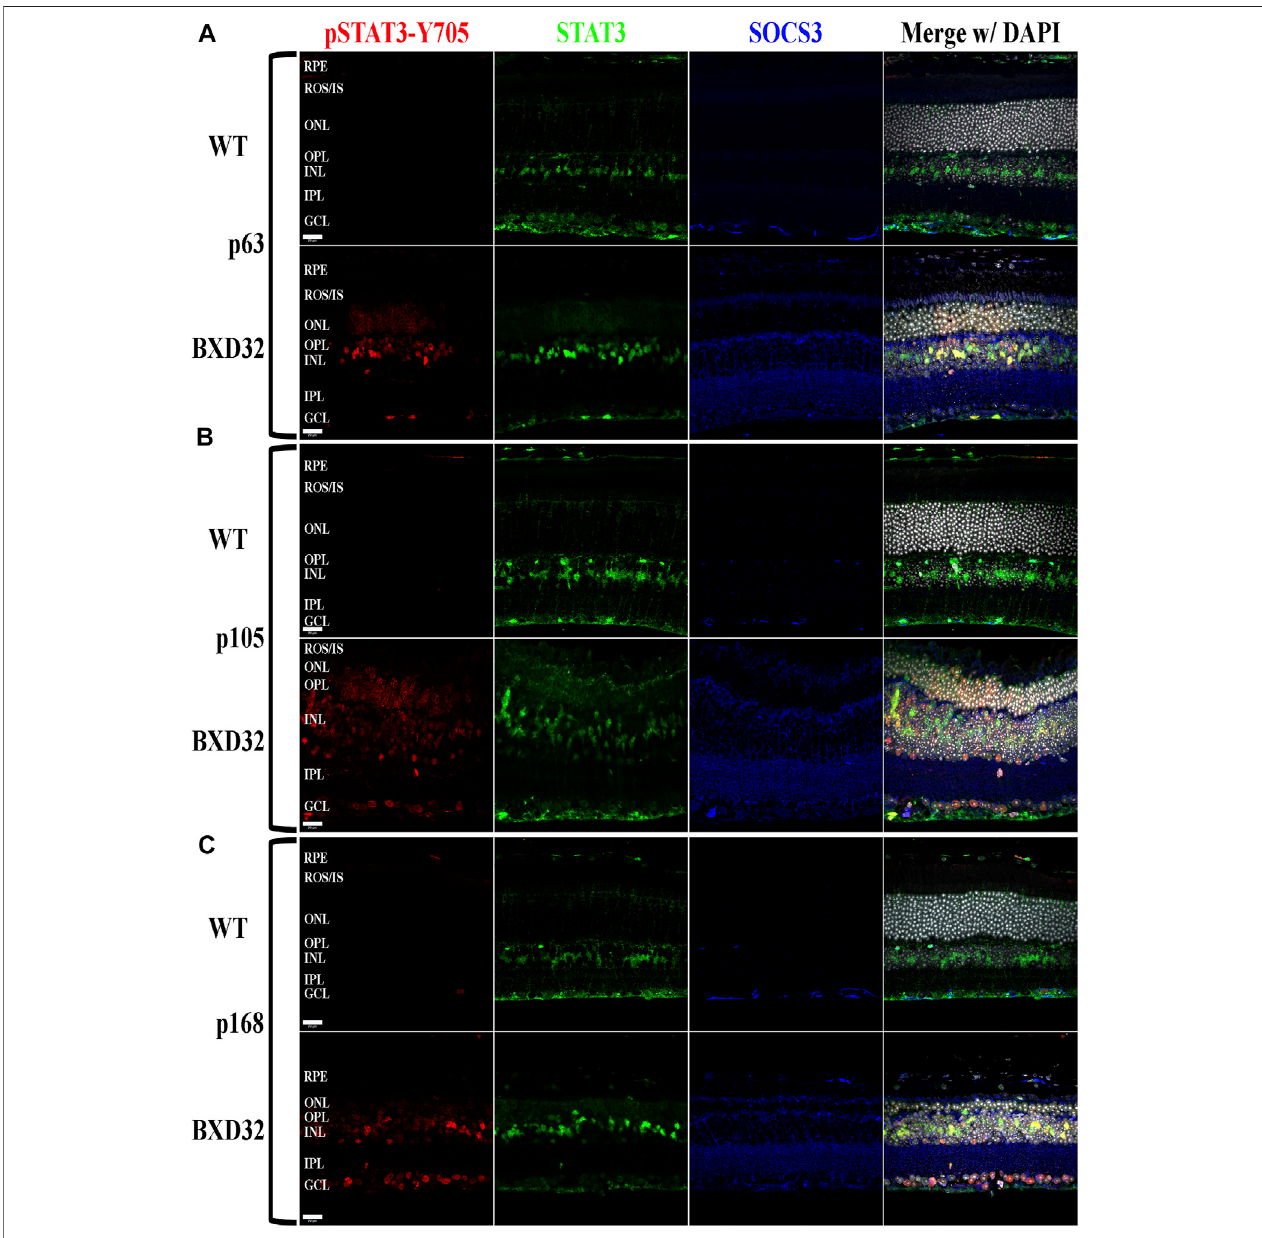
FIGURE8| ActivationofSTAT3byJAKphosphorylationisobservedintheBXD32mouseretina.UsingimmunolabelingforpSTAT3attyrosine705(pSTAT3-Y705, red), total STAT3 (green) and the inhibitory protein SOCS3 (blue), the BXD32 mouse retina exhibits both increased expression of total STAT3 and the inhibitory protein SOCS3, while also having substantial STAT3-Y705 phosphorylation which increases with age from p63 (A) to p105 (B) up through p168 (C) . This pSTAT3 labeling is observed in multiple cell layers of the retina including the ONL, INL and GCL. Nuclei stained with DAPI (white/grey). RPE, retinal pigment epithelium; ROS/IS, rod outer segments/inner segments; ONL, outer nuclear layer; OPL, outer plexiform layer; INL, inner nuclear layer; IPL, inner plexiform layer; GCL, ganglion cell layer. Scale bars = 20 μ m.